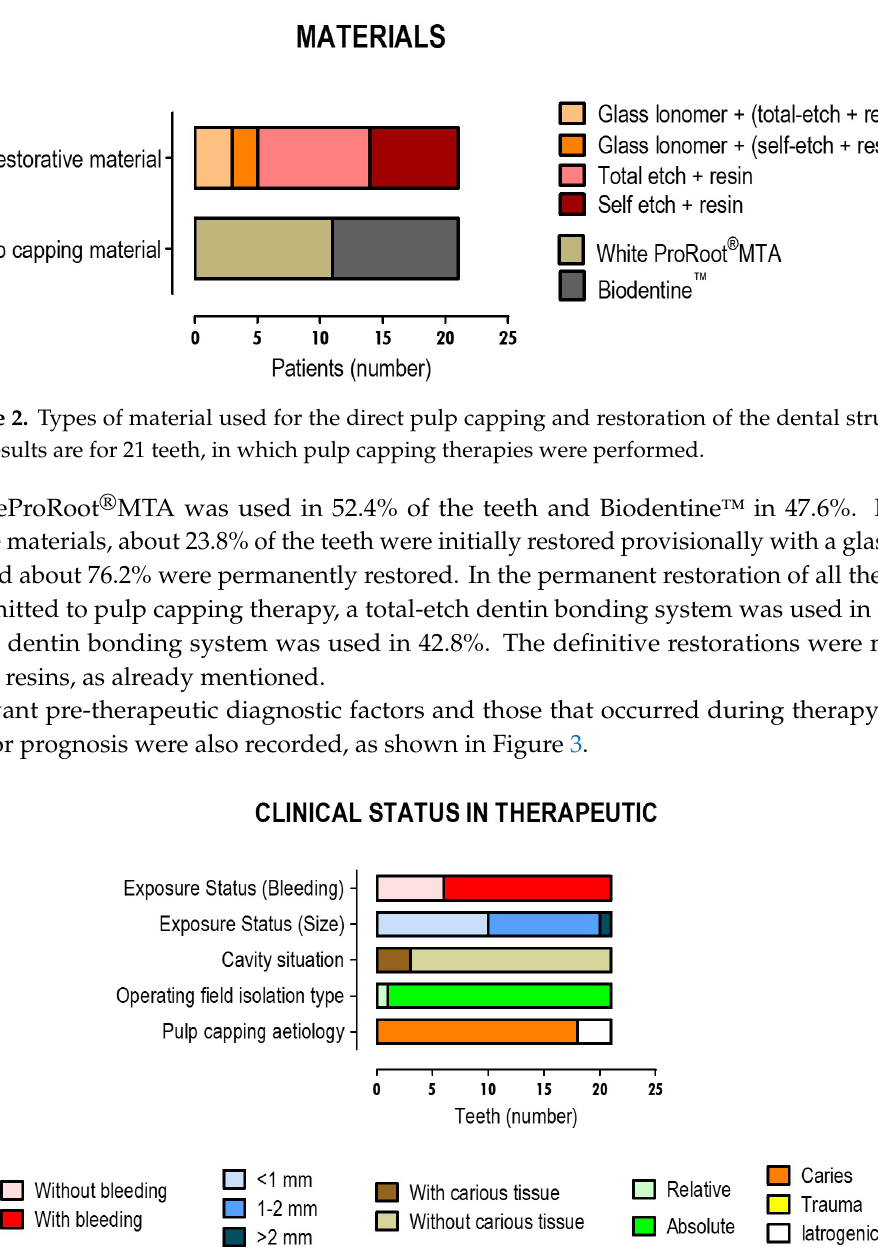
Figure 3. Diagnostic factors of pre-therapeutic clinical status, such as the cause of pulp capping and the type of isolation performed; and relevant clinical factors for prognosis, such as cavity status and pulp exposure status (size and bleeding). The results correspond to 21 teeth in which pulp capping therapies were